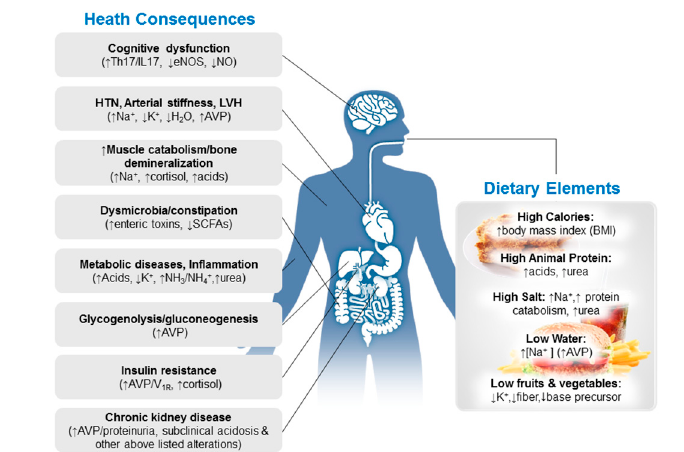
Figure 1. Multisystemic effects of the modern diet, characterized by high calorie, animal protein, and salt but insufficient water, fruits and vegetables ( Right ). Key alterations in multiple organ systems ( Left ) may be elicited by the modern diet.